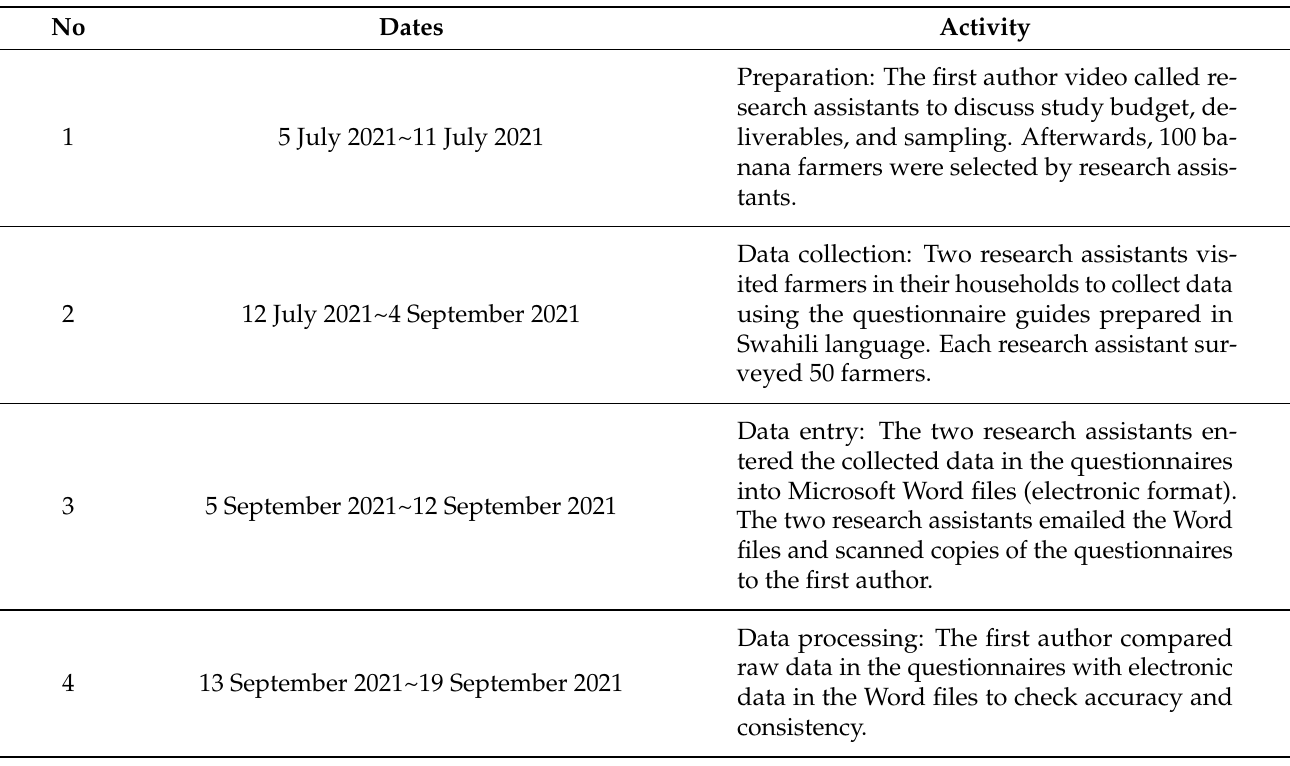
Table 1. Timetable of the fieldwork.